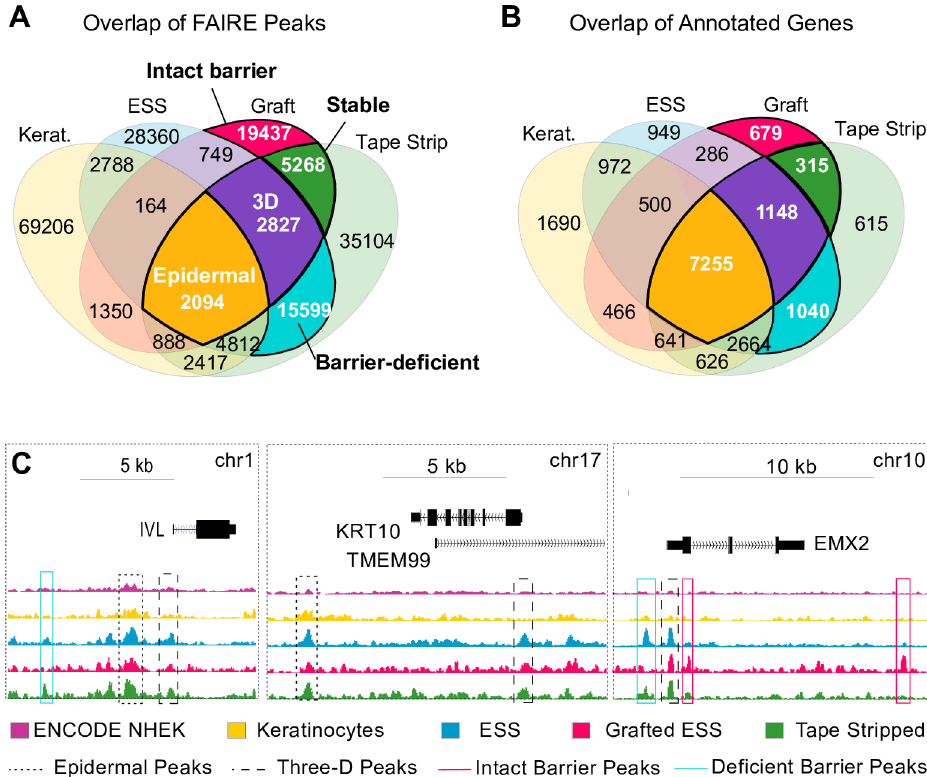
Fig 3. Dynamic FAIRE peaks in barrier maturation and function. (A) Venn diagram demonstrating overlap of FAIRE peaks in each sample and 5 relevant peak classes basedon tissue pattern: Epidermal (n = 2094), Three-dimensional (3D; n = 2827), Stable (n = 5268), Intact Barrier (n = 19437), and Barrier- deficient(n = 15599). Peaks present in any non-epidermal cell type were filtered out prior to analysis. (B) Venn diagramshowingoverlap of annotated genes for each sample type. The nearest gene was assignedto each peak using Homer annotatePeaks. (C) FAIRE signalswith representative peaks from four categories: Epidermal, dotted line; Three-dimensional,dashedline; Intact barrier, pink line; and Barrier-deficient peaks, blue line.